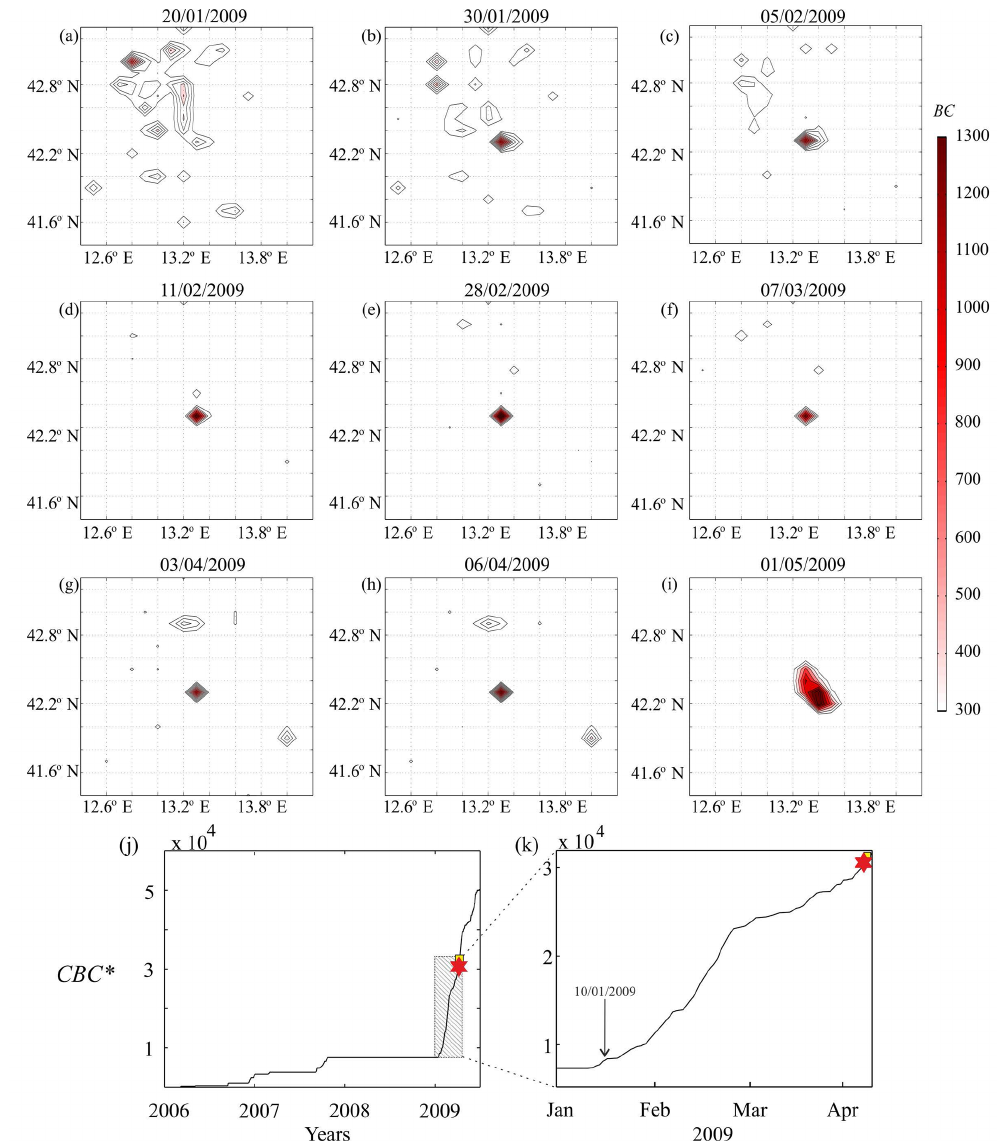
Figure 5. Betweenness centrality (BC) computations in the space window centered at the mainshock epicenter (42.42 ◦ N, 13.39 ◦ E) with radius R 1 = 1 ◦ : (a–i) snapshots of the BC maps for each cell from 20 January to 1 May 2009; (j, k) cumulative BC computed at the mainshock cell (CBC ∗ ) from 1 January 2006 to 30 June 2009 (j) and from 1 January to 6 April 2009 (k) . The mainshock occurred on 6 April 2009 (red